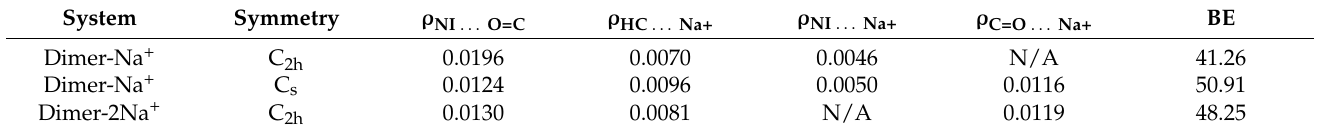
Table 4. Metal ion binding energy, BE (kcal/mol), and electron density at bond critical points, ρ (a.u), for Na + binding by the cyclic dimer of the model system, ((HOOC) 2 -C 6 H 2 -(NHI) 2